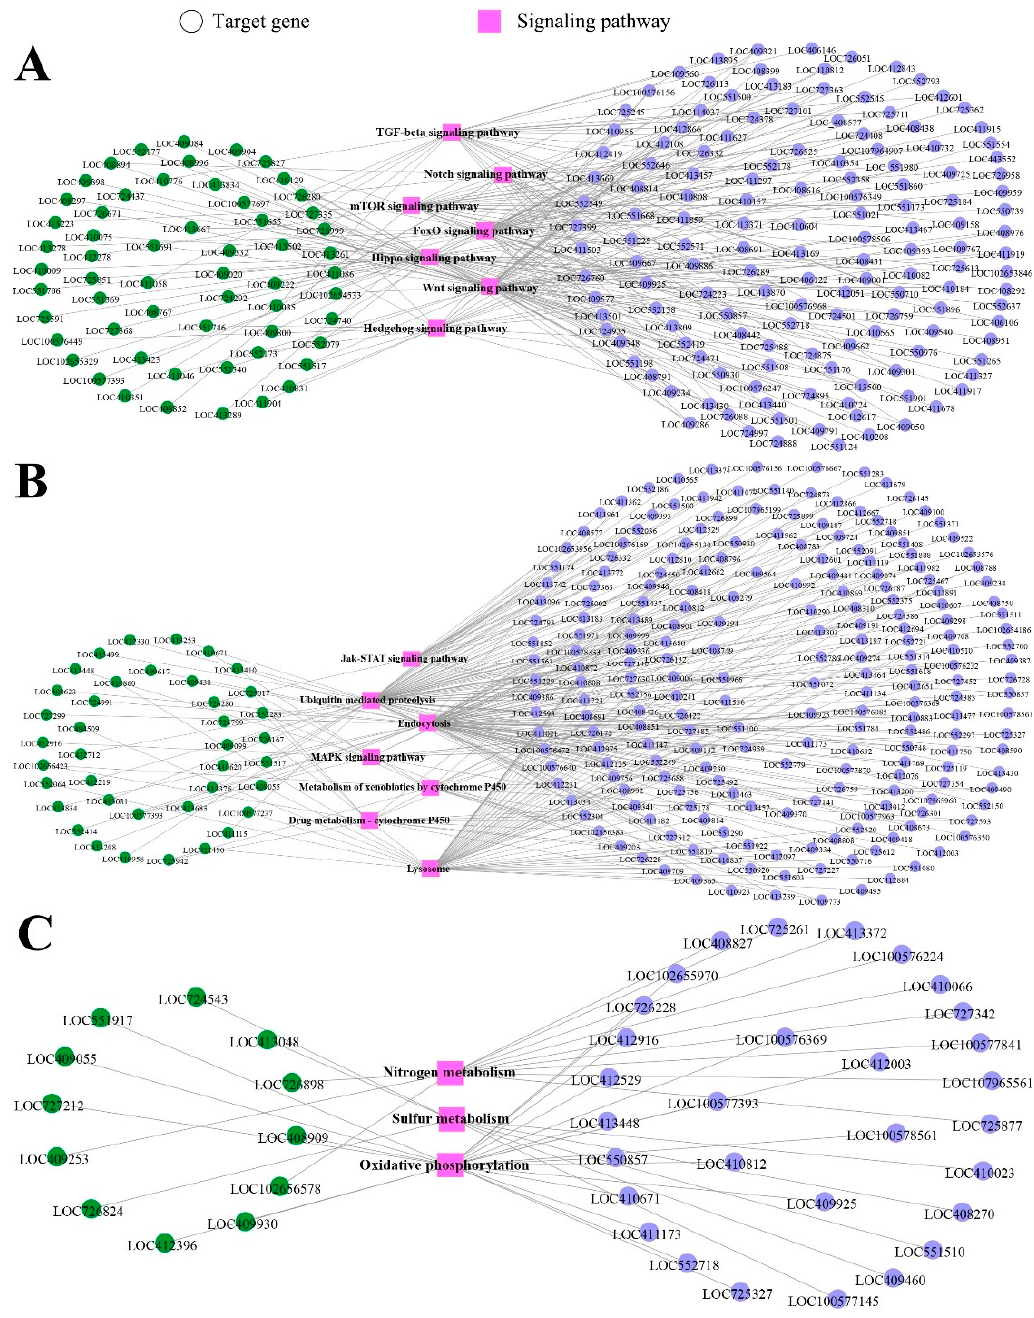
Figure 5. Regulatory networks of target genes of DEpiRNAs in the “Am4 vs. Am5” and “Am5 vs. Am6” comparison groups. ( A ) Regulatory network of DEpiRNAs and the corresponding targets relative to development-associated pathways. ( B ) Regulatory network of DEpiRNAs and the corre- sponding targets relative to immune-associated pathways. ( C ) Regulatory network of DEpiRNAs and the corresponding targets relative to energy metabolism-associated pathways. Only target gene ID and pathway names are presented while piRNA ID were omitted to make regulatory networks clearer. Purple circles indicate the target genes of DEpiRNAs in the “Am4 vs. Am5” comparison group, green circles indicate target genes of DEpiRNAs in the “Am5 vs. Am6” comparison group, while pink squares indicate signaling